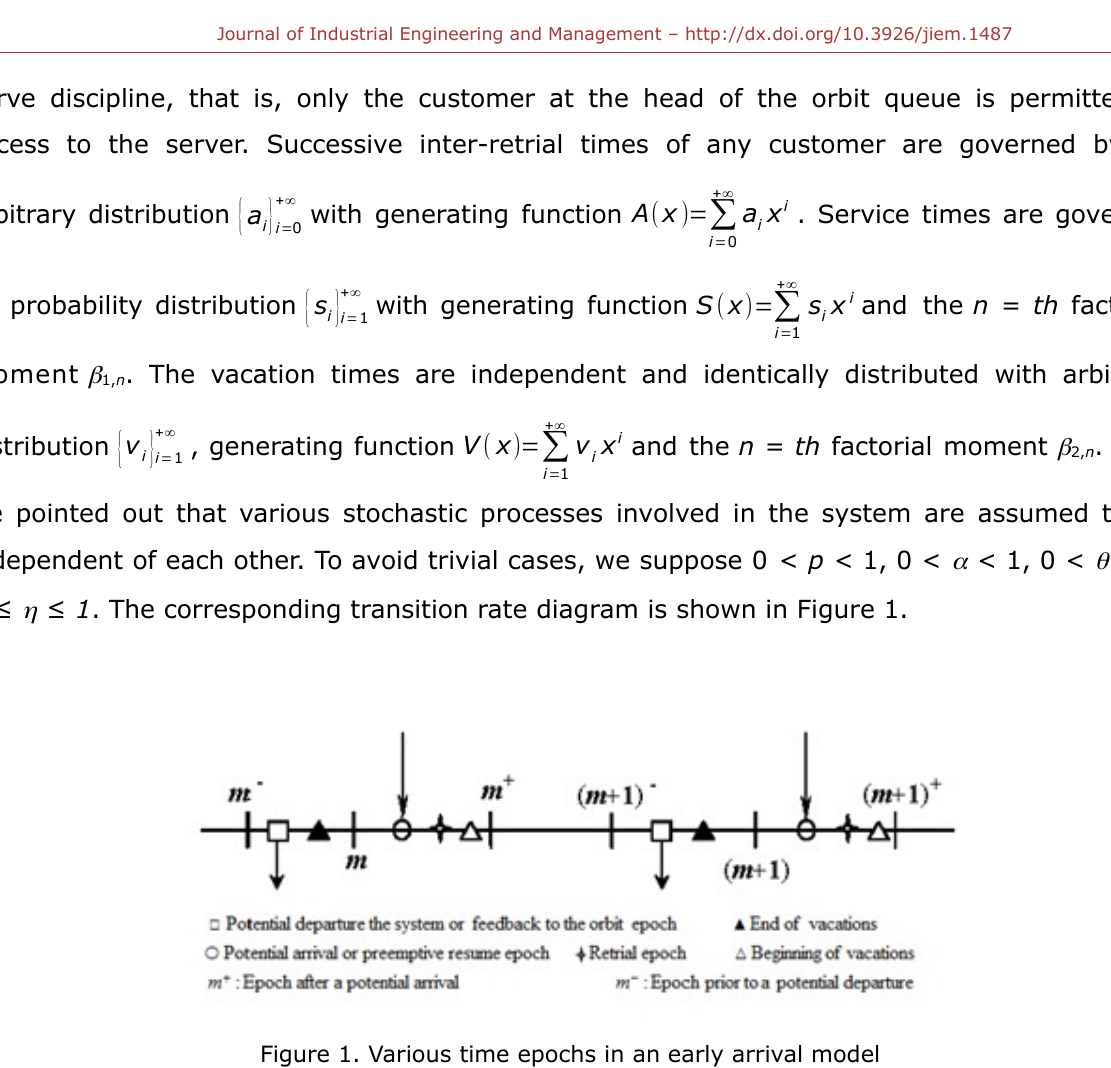
Figure 1. Various time epochs in an early arrival